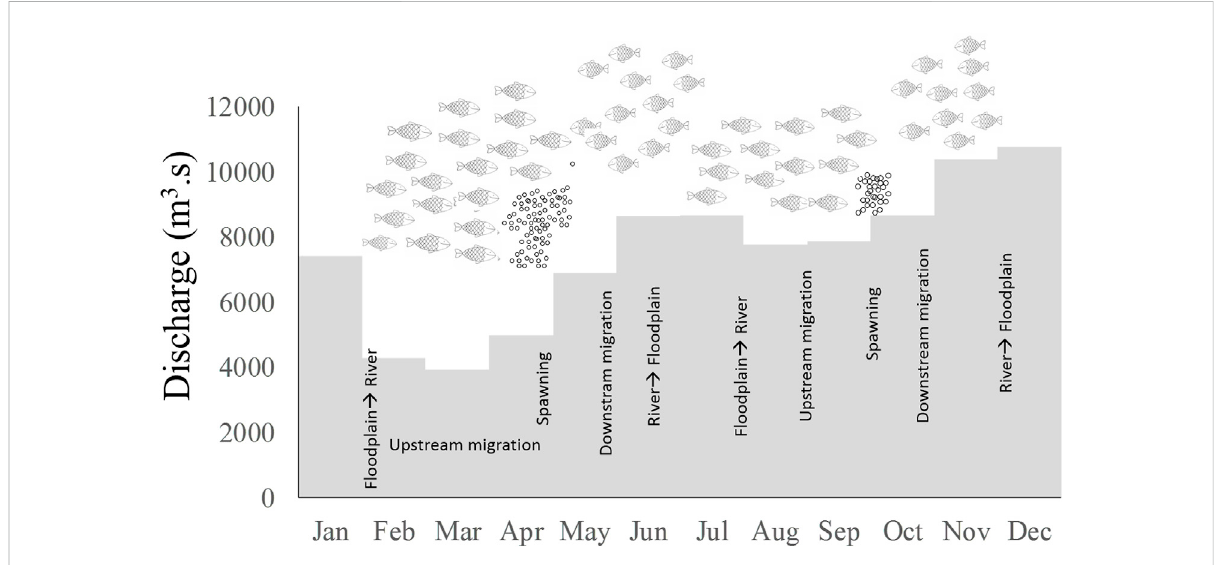
FIGURE 5 Migration cycle of potamodromous fi sh in the Magdalena River and hydrologic seasonality. Gray bars: Mean of the monthly discharge in the Magdalena River in the period 2003 – 2014. Adapted from Jiménez-Segura et al.